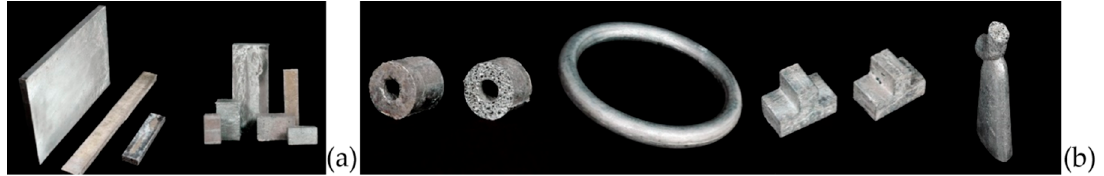
Figure 10. Simple thin foam panels (e.g., 210 × 250 × 15 mm 3 and 300 × 35 × 15 mm 3 ) and foam blocks (e.g., 200 × 50 × 50 mm 3 and 80 × 50 × 50 mm 3 ) ( a ) and complex foam parts (e.g., steering wheel 250 mm in outer diameter) ( b ).